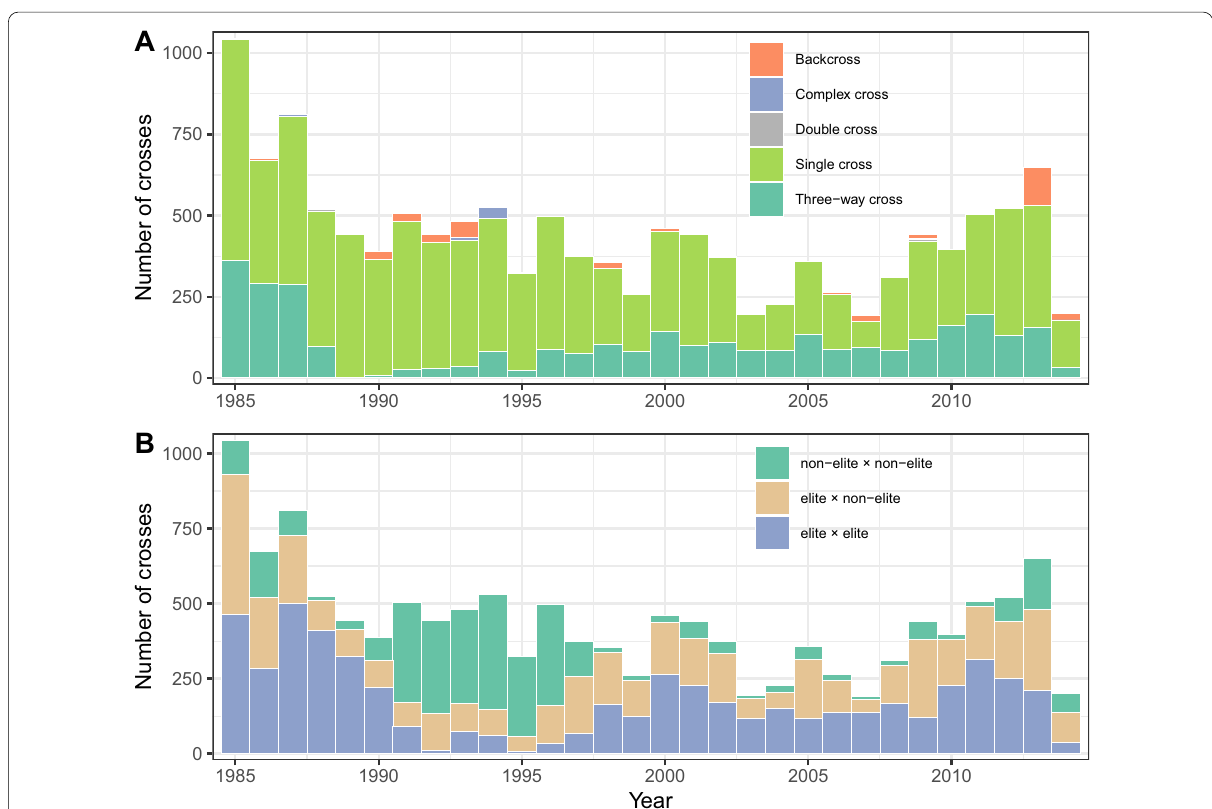
Fig. 4 Evolution of the crossing strategy between 1985 and 2014 for IRRI’s irrigated breeding program. The cross type ( A ) and cross status ( B ) are represented. The cross status has been defined based on the equivalent complete generation (EqG) of the two parents (see “Materials and Methods”